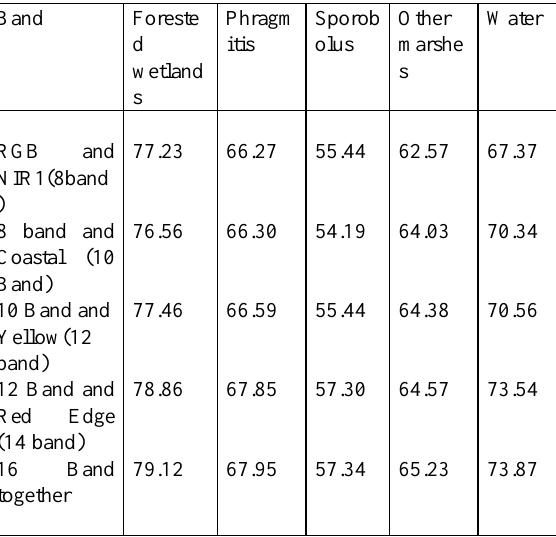
Table 6. Mapping Accuracy (%) of Hyperion data